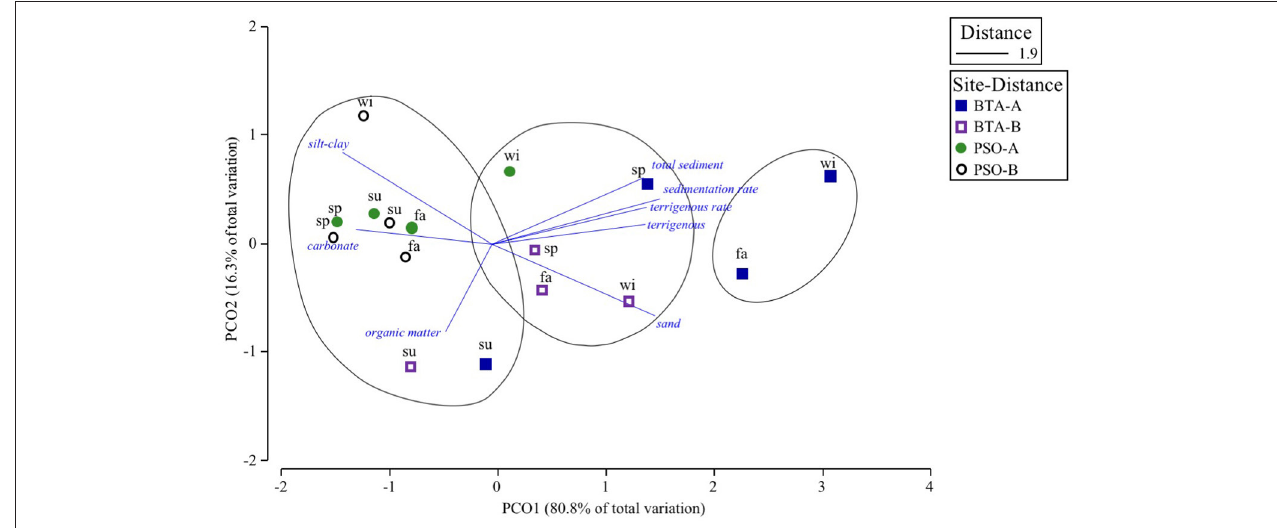
FIGURE 4 | Principal coordinate ordination (PCO) analysis of centroids of sedimentation components by seasons, sites and distance zone from shore based on Euclidean assemblage data. Squares represent BTA and circles PSO. Clusters based on a Euclidean distance cutoff level of 1.9. This model explained 97.1% of the observed spatio-temporal variation in sedimentation patterns. Seasons are represented as sp, spring; su, summer; fa, fall; wi, winter.